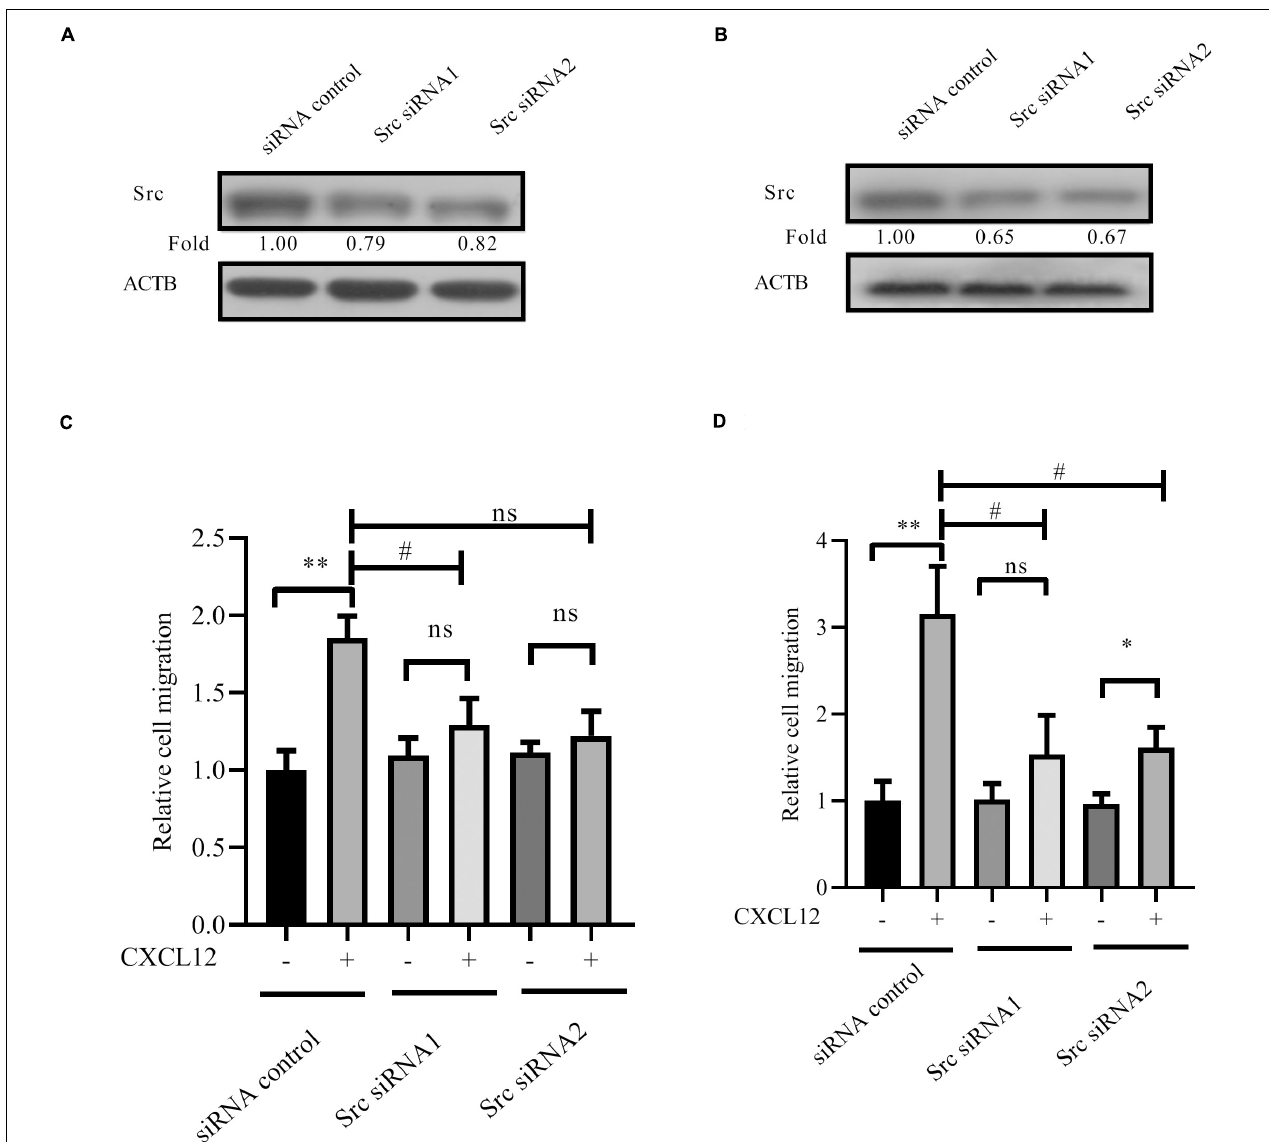
FIGURE 6 | Knockdown expression of Src by siRNAs inhibited CXCR4-mediated T-ALL migration toward CXCL12. (A,B) siRNAs were transfected into JURKAT or CCRF-CEM cells using the methods described in the materials and methods section; 48 h after transfection, cell lysates were prepared for Western blot assay to detect the interference efficiency of siRNAs on Src. (C,D) Transfected cells were used in the transwell assay. Each experiment was repeated at least three times. Western blot bands were analyzed using Image Pro Plus 6.0, and fold changes of Src were normalized according to ACTB. ACTB was used as the loading controls. * p < 0.05, ** p < 0.01, comparing with the negative control (CXCL12 − ) group. # p < 0.05 comparing with the positive control (CXCL12+)